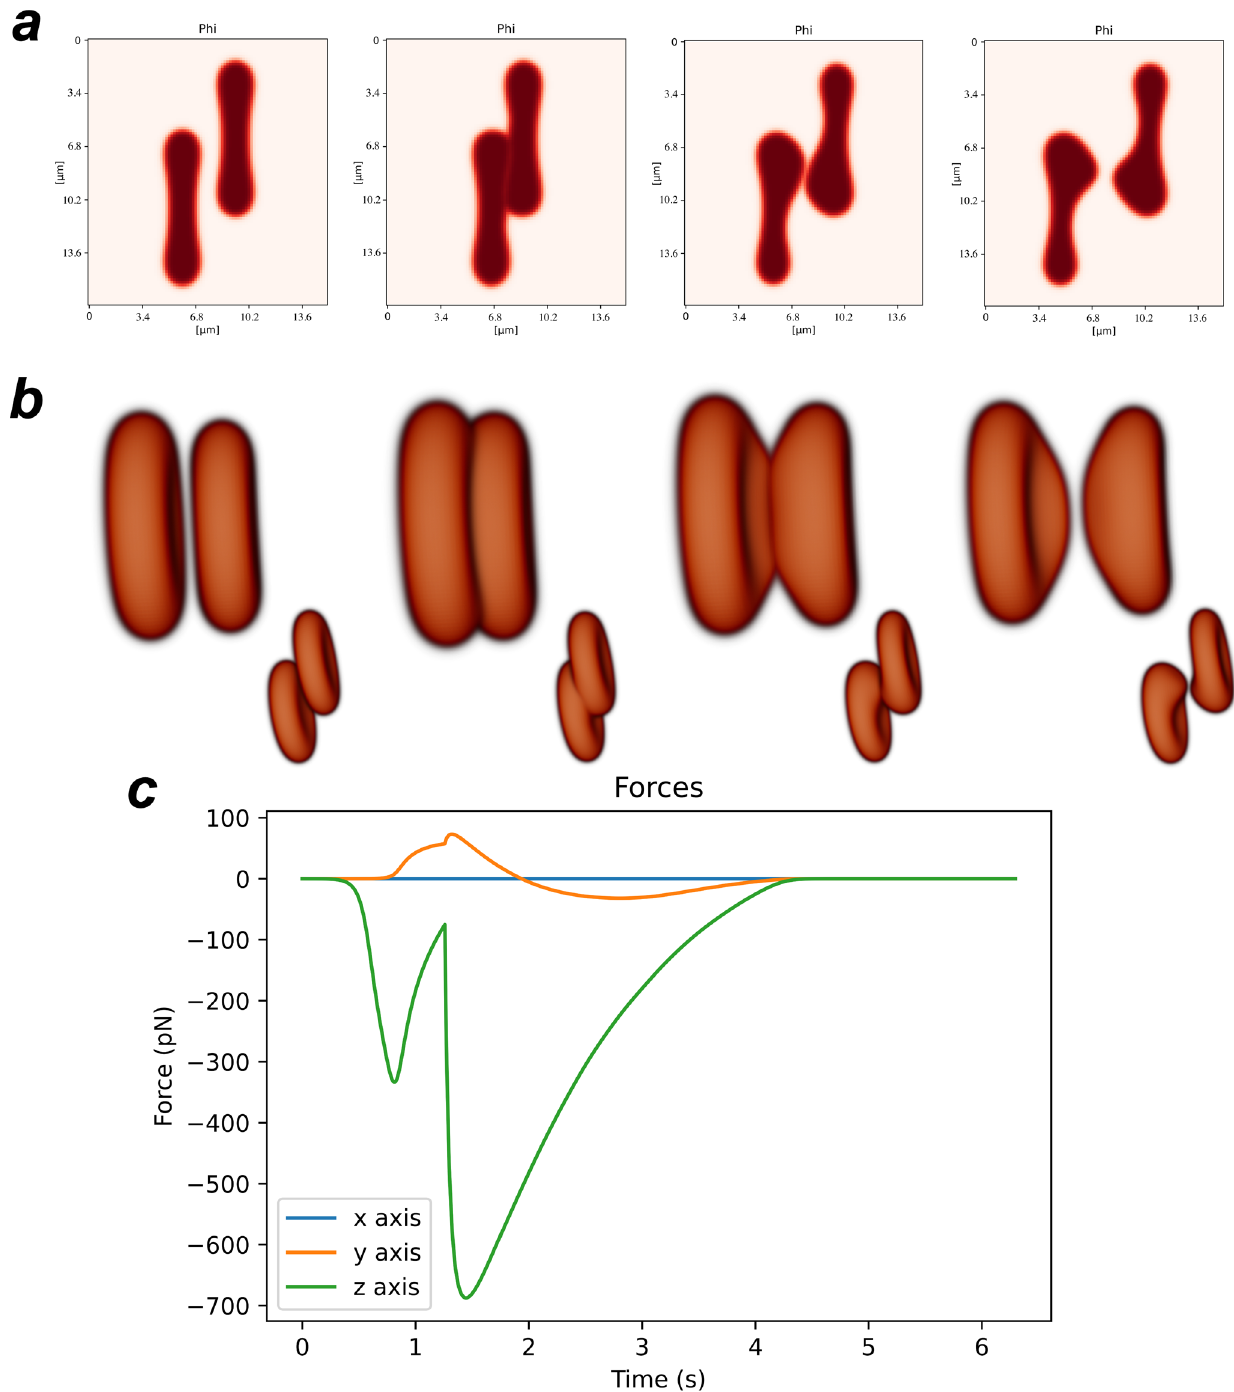
Fig. 6 Simulation time-lapse of two offset erythrocytes being pushed against each other off centred and then pulled apart for large adhesion. a Mid- slice pro fi le and b corresponding 3D representation with offset distance d = 4.08 μ m (at each time instance, we present the erythrocytes observed from two different perspectives: observed along the y direction, in the larger images, and when observed along the x direction, in the respective smaller images). The images correspond to the times t = 0, 1.25, 3.13, and 4.69 s. c Total force applied on the right erythrocyte by the left erythrocyte as a function of the 15 min. Then, the cantilevers were incubated overnight in a 0.5mg/mL biotinylated albumin solution, at 37 °C, in a humidi fi ed incubator. The cantilever was washed three times in phosphate buffered saline (PBS) pH 7.4 to remove unbound protein. After that, the cantilever was incubated in 0.5mg/mL streptavidin (30 min, at room temperature) and, fi nally, in 0.4mg/mL biotinylated-concanavalin A solution (30 min, at room temperature). Functionalised cantilevers were mounted on the viously described 18,22,53 . AFM cantilevers were cleaned with intense UV light for microscope, the erythrocytes in suspension were injected, and one erythrocyte was